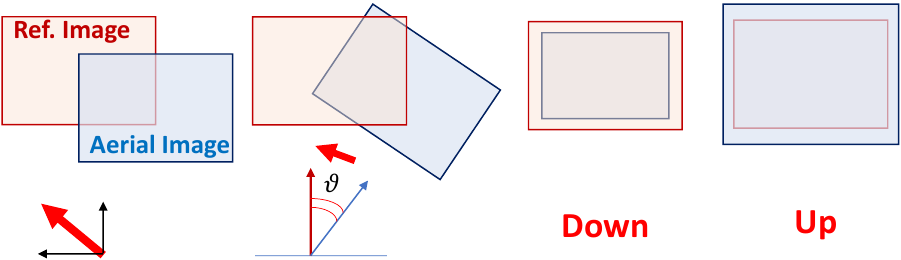
Figure 4. Illustration of UAV steering control from image registration outcomes under similarity transformation. From left to right images: the UAV steering control due to partial scene overlapping, rotation, scale less than unit, and scale greater than unit with respect to the georeferenced